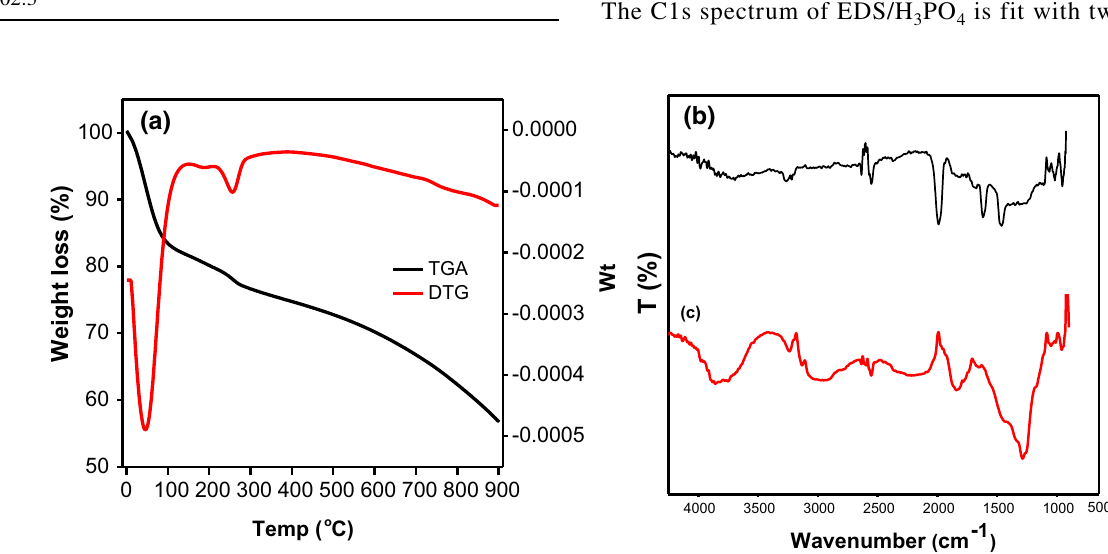
Fig. 3 a TGA/DTG analysis curves DES/H 3 PO 4 -600 2:3 based activated carbon; FTIR of AC-600 2:3, b before adsorption, c after